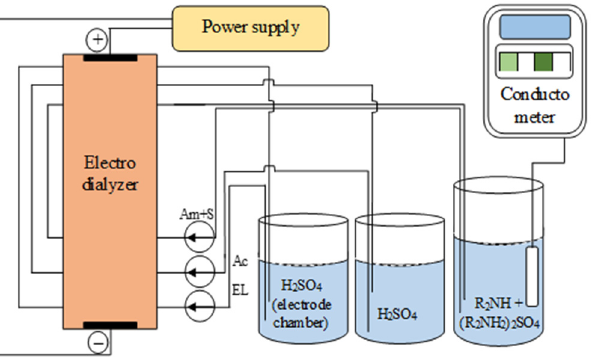
Figure 5. Hydraulic circuit of an electrodialyzer designed to produce amine and sulfuric acid from an amine salt. EL is the electrode chamber solution cycle, Am + S is the base-salt solution cycle, Ac is the acid solution cycle.